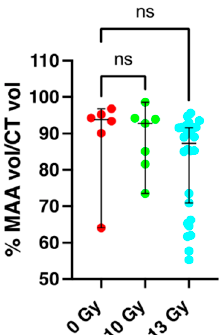
Figure 2. Percent perfused lung volume by radiation (Y-axis) as determined by 99m Tc-MAA and CT imaging. The data are presented as medians and 95% confidence intervals in female nonirradiated rats and age-matched rats given 10- and 13-Gy whole thorax lung irradiation (WTLI) at 2 weeks after exposure. There was no difference in perfusion between groups when all rats in each group were included. ns = no statistical difference.